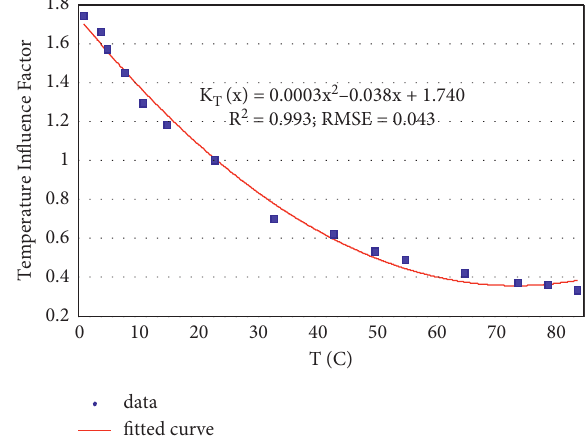
Figure 18: Temperature influence factor on electric resistance